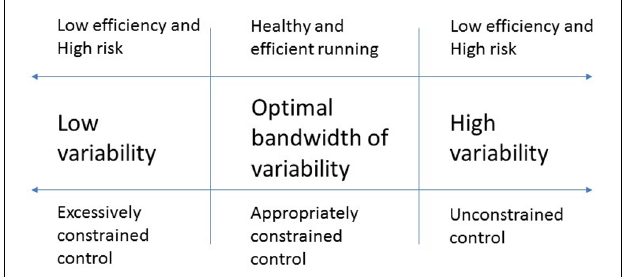
FIGURE 3 | Relationships between running gait variability, risk and